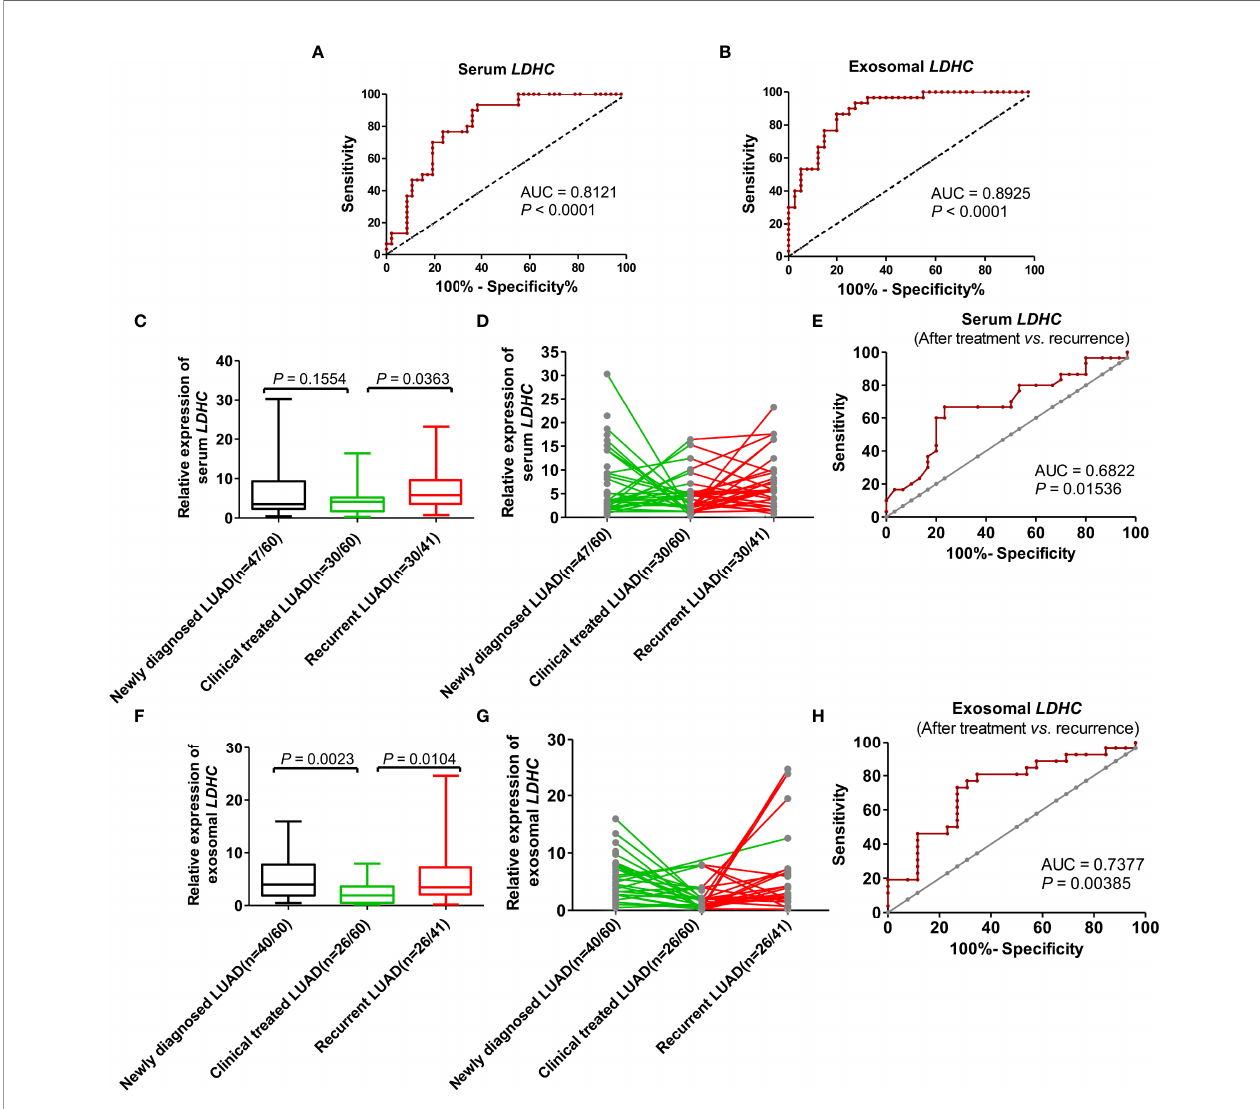
FIGURE 4 | The value of serum and serum-derived exosomal LDHC in diagnosis, ef fi cacy evaluation, and recurrence monitoring of LUAD. ROC curve showed the diagnostic ef fi cacy of (A) serum and (B) exosomal LDHC in distinguishing LUAD patients from healthy controls. The expression of (C, D) serum LDHC in patients with LUAD at fi rst visit, after treatment and relapse. (E) The ef fi cacy of serum LDHC in predicting recurrence in patients with LUAD after treatment. Expression of (F, G) exosomal LDHC in patients with recurrent LUAD. (H) The ef fi cacy of exosomal LDHC in predicting recurrence in patients with LUAD after